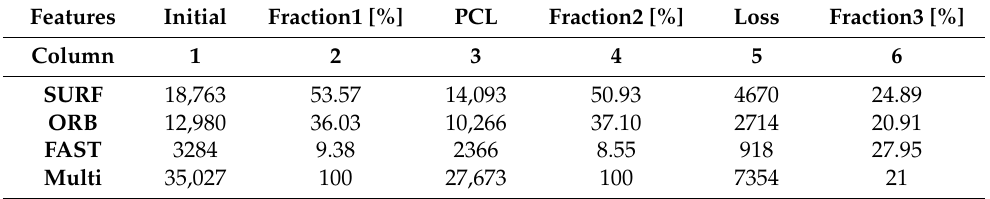
Table 6. The features accumulation and contribution to the point cloud of EPFL dataset applied.